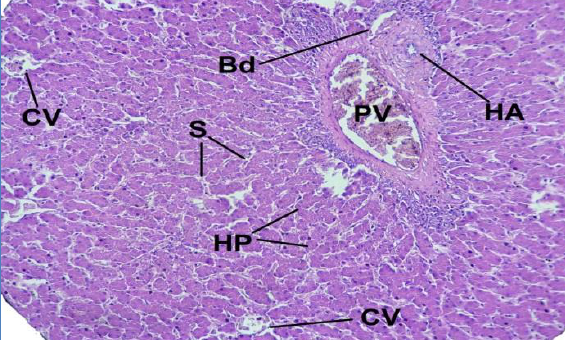
Figure, 12: Histological section of the liver in mallard duck shows, the portal triad. Portal vein (PV), hepatic artery (HA), bile duct (Bd) and central vein (CV) sinusoids (S). hepatic plate (HP) (H and E 20X).